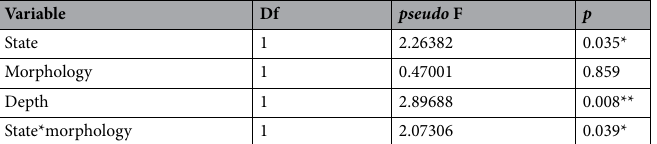
Table 3. Results of the PERMANOVAs test for the influence of the fixed components environmental state and reef morphology on acoustic communities. The PERMANOVAs was based on log-standardized relative